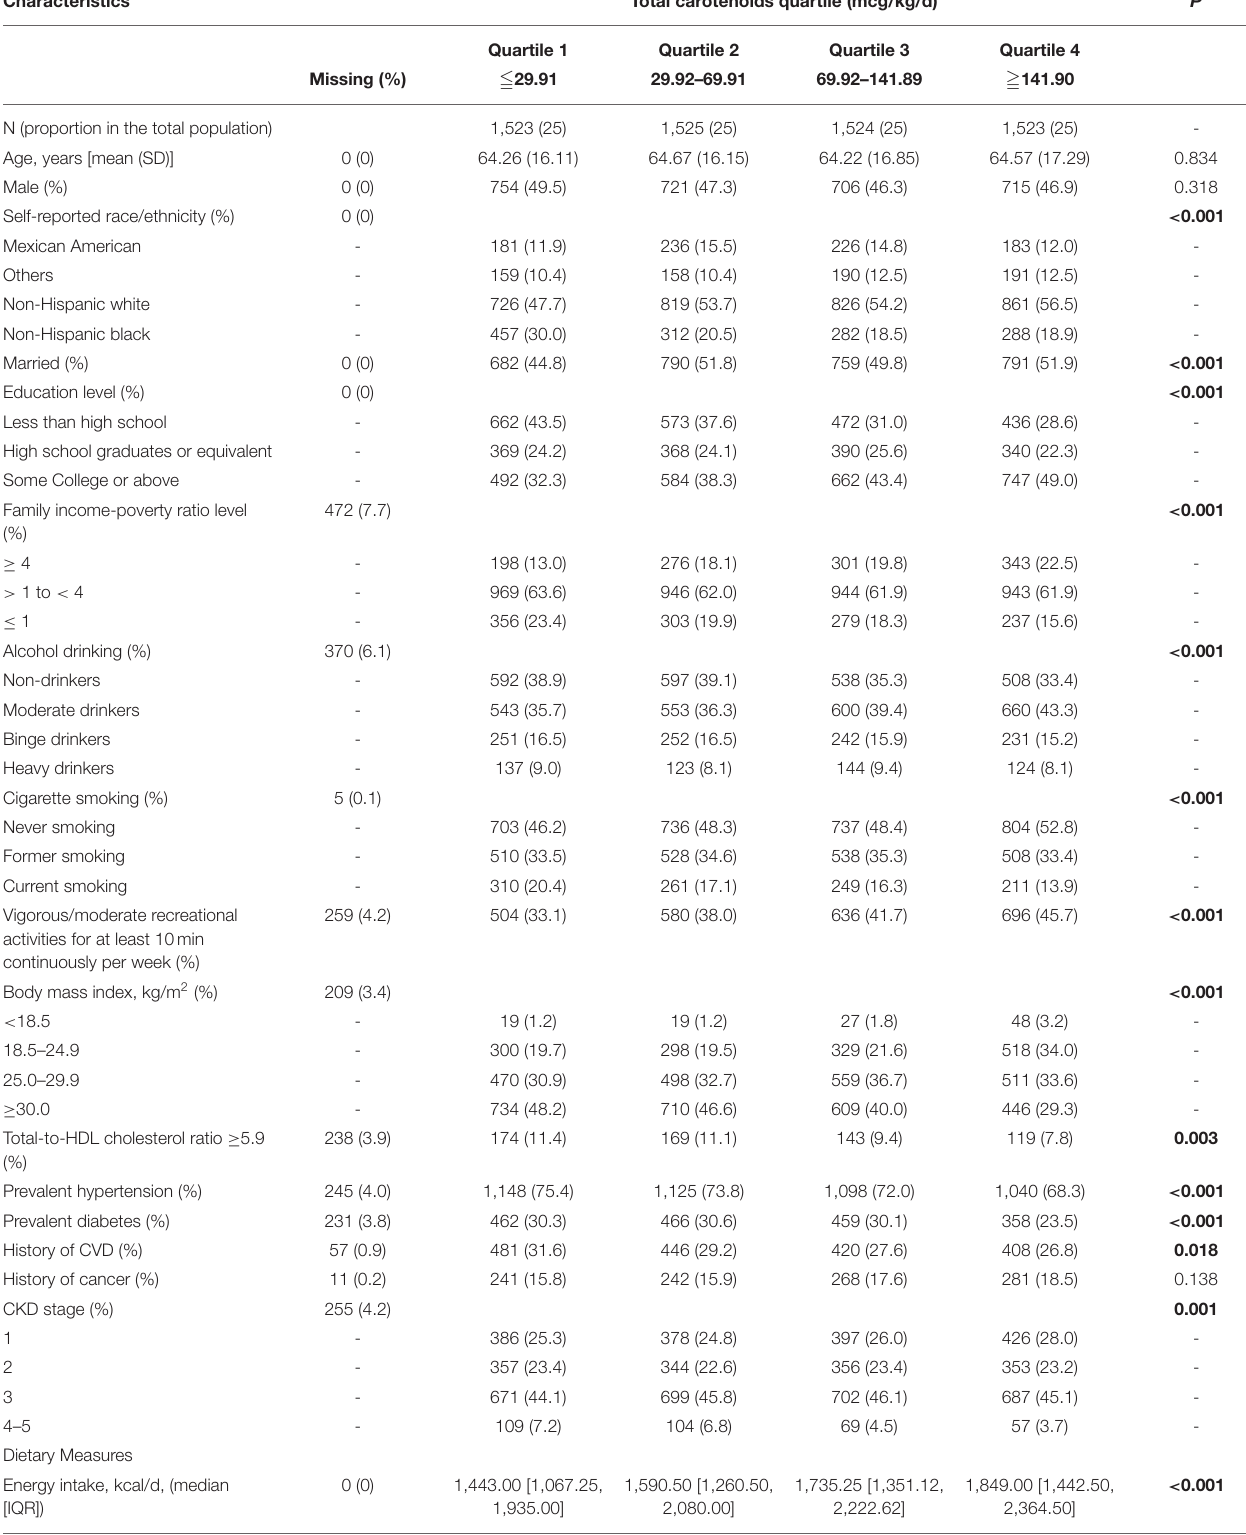
TABLE 1 | Baseline characteristics of participants by quartiles of total carotenoids, NHANES, 2001–2014.